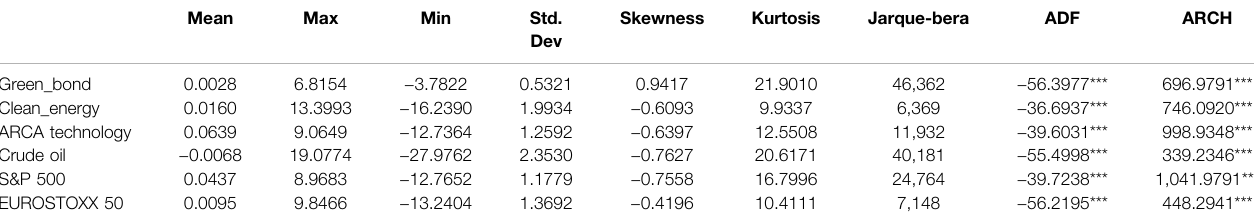
TABLE 1 | Summary statistics of daily returns.